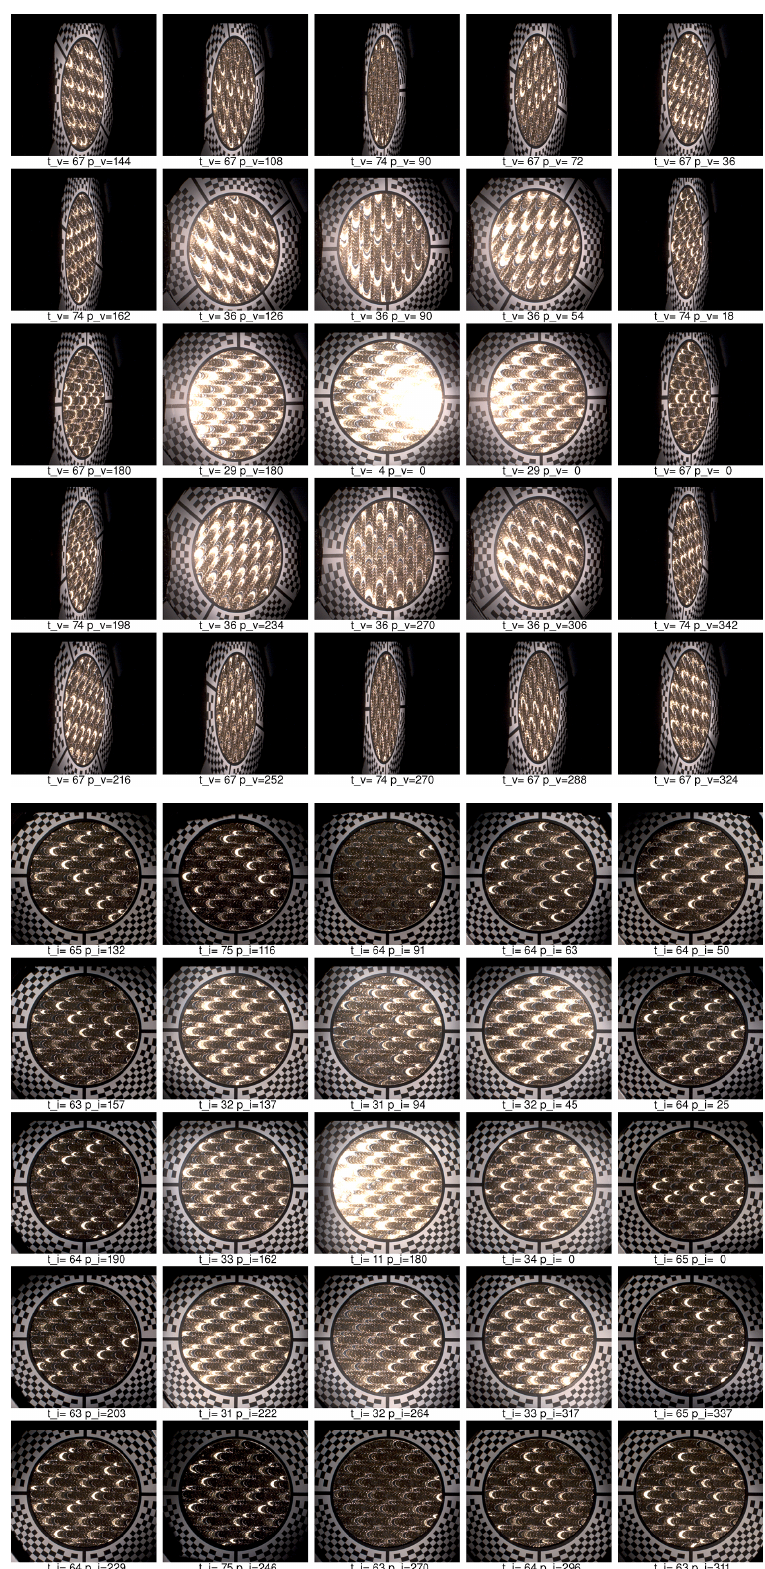
Figure 24. The example measurement data on example material sample 011-Silver-Gold from The MAM 2014 sample set ([35]). ( top ) changing the viewing direction for illumination direction close to the normal for θ i = 12.5 ◦ ; ( bottom ) changing the illumination direction, the camera at direction θ v = 3.5 ◦ , φ v = 1 ◦